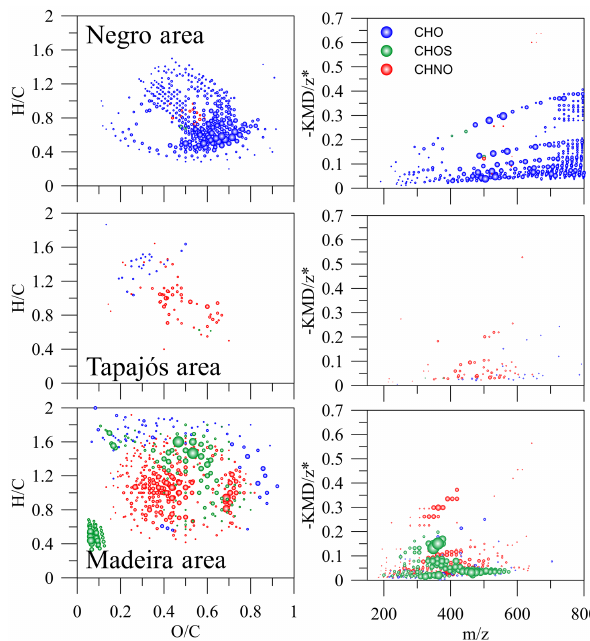
Figure 3. Unique m/z ions analyzed by FT-ICR-MS of solid-phase extracted DOM associated with the three different Amazon